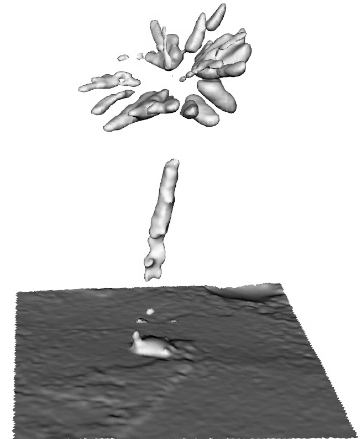
Figure 10. Model of Pachypodium lamerei .